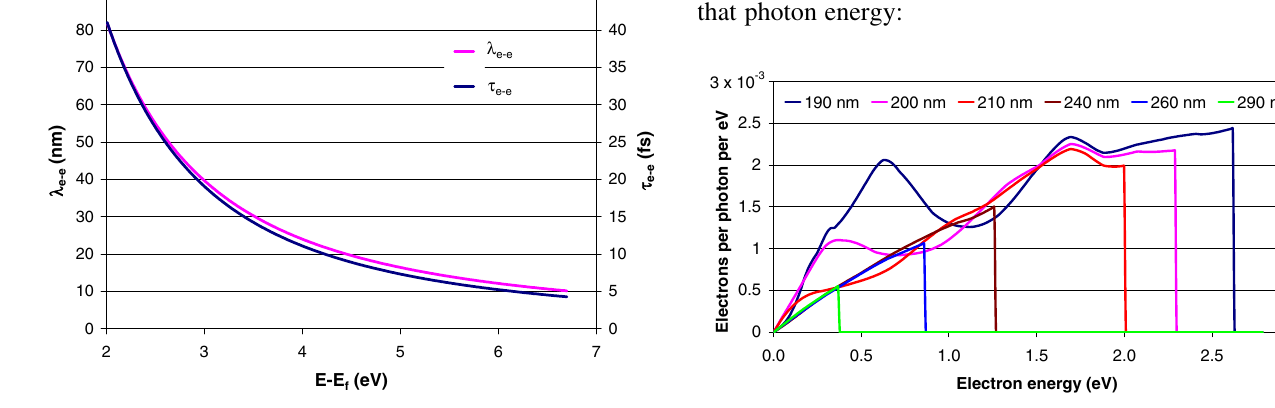
) and FIG. 3. (Color) Calculated energy distribution curves for lead e - e irradiated with various wavelengths of